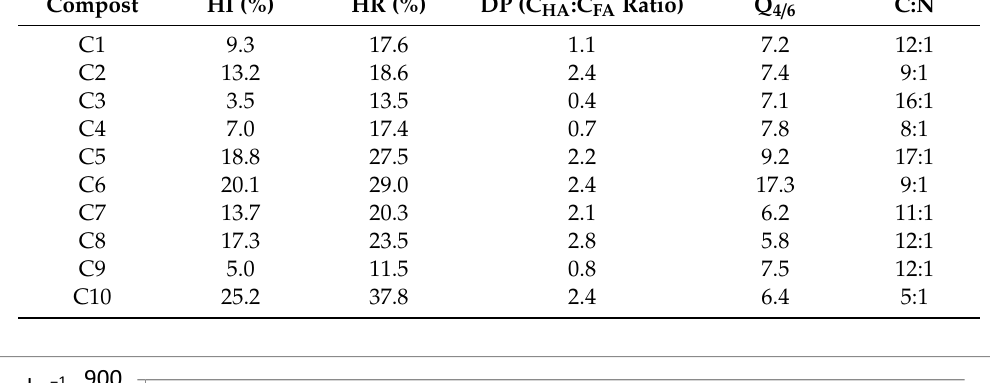
Figure 1. Contents of organic matter and total organic carbon in analysed composts.